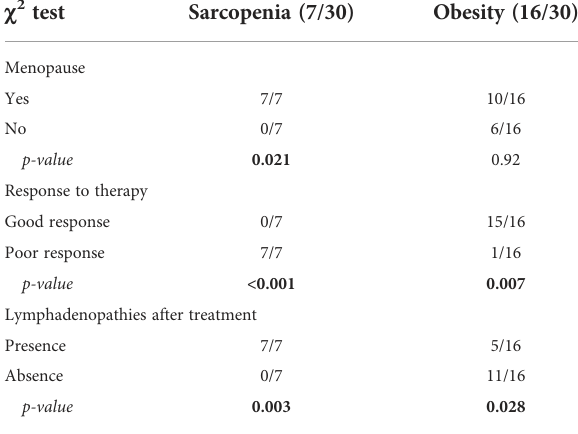
TABLE 3 Association between sarcopenia and obesity and clinical parameters.